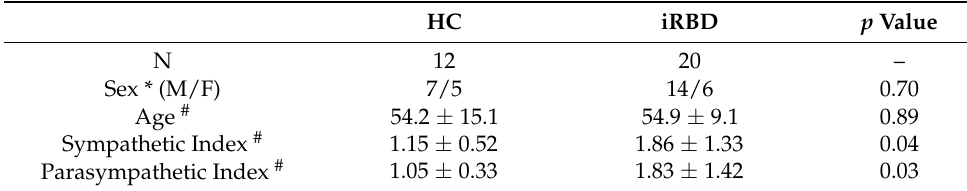
Table 1. Demographic and HRV data of enrolled